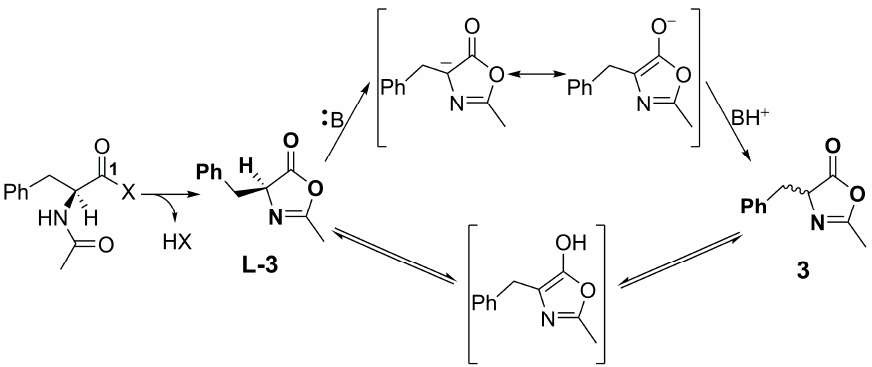
Figure 4. Theorized azlactone formation during the activation of N -Ac- L -phe with TBTU. X is the activating–leaving group.